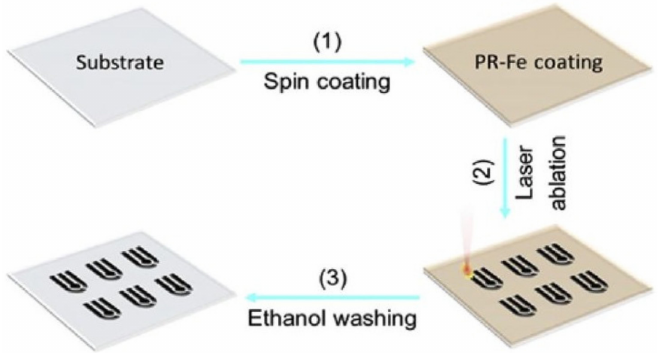
Figure 8. Schematic diagram of the fabrication process of the LIG patterns using visible light 305 nm semiconductor lasers [89]. Copyright 2018 Elsevier.